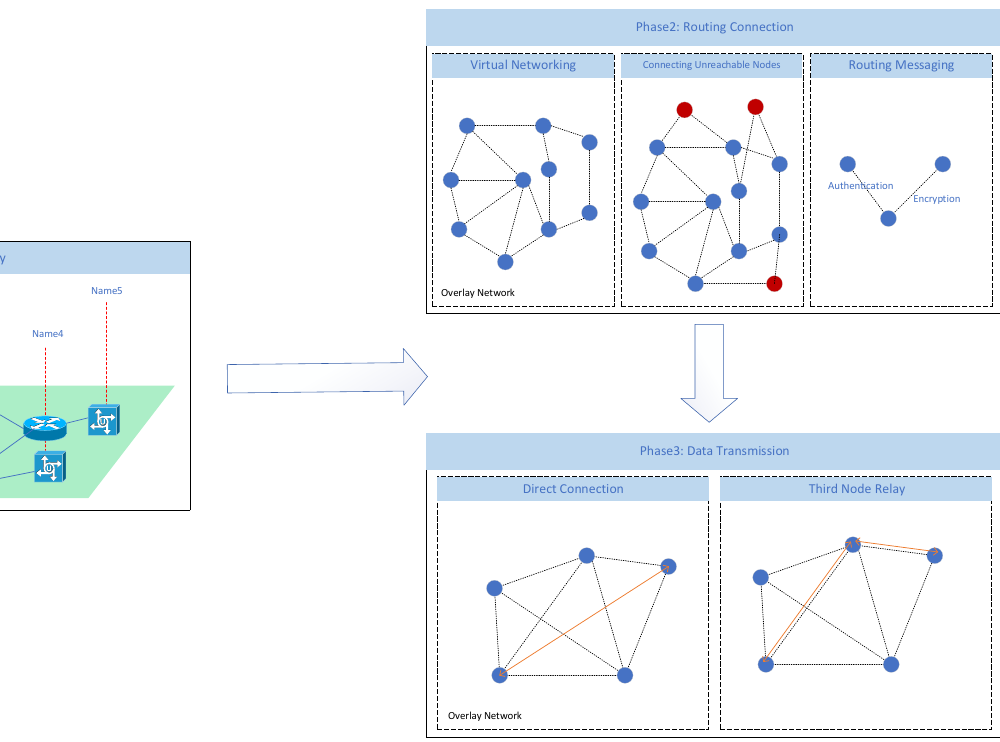
Figure 4. The overview of the system